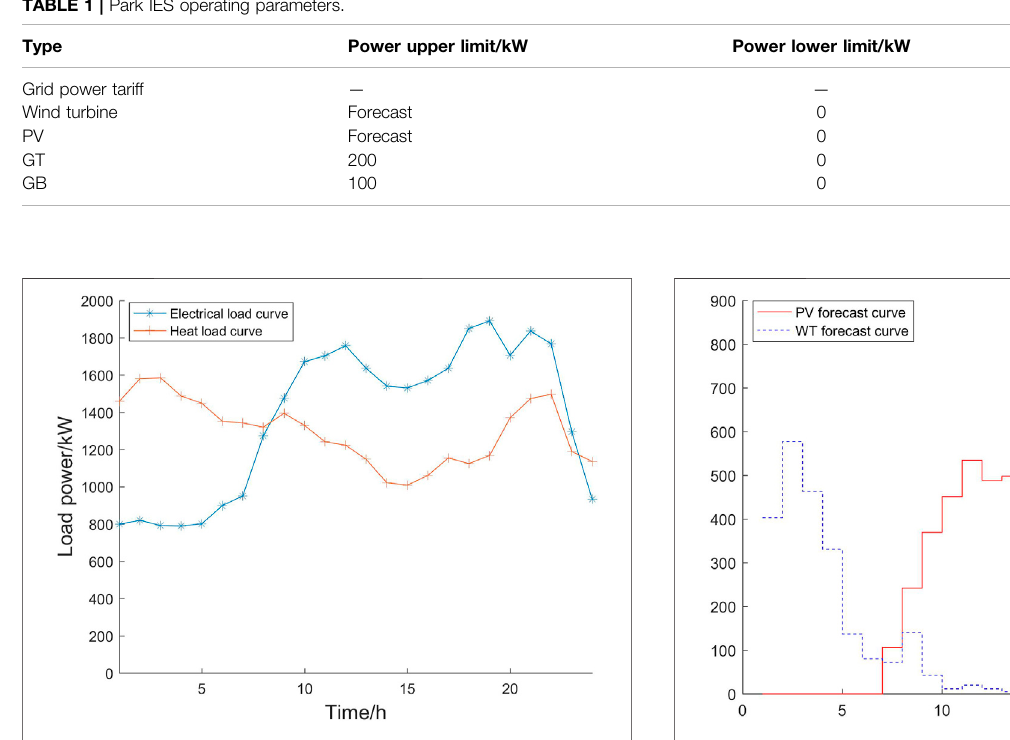
FIGURE 2 | Typical user daily load curve. FIGURE 3 | New energy forecast.